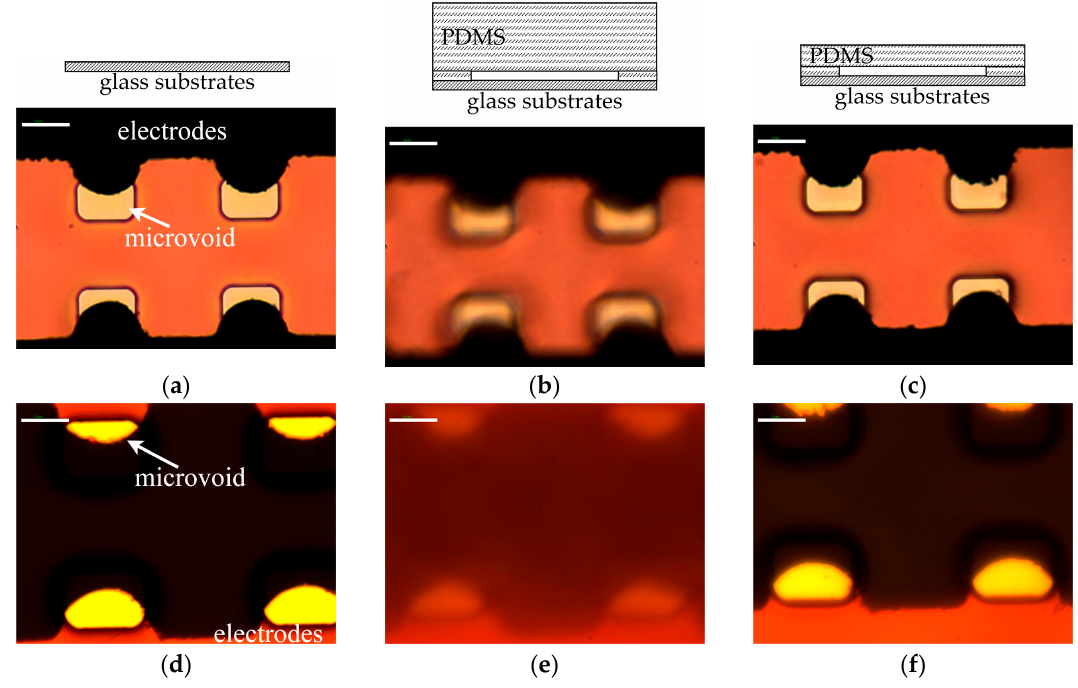
Figure 6. Photographs of Au microelectrodes with microvoids via the objective of ×100/0.6, scale bar: 10 μ m. Microscope images with transmission illumination mode: ( a ) on the glass substrate; ( b ) on the microfluidics chip with a 3 mm thick PDMS block; and ( c ) on the microfluidics chip with a 300 μ m observation interface of a PDMS membrane. Microscope images with reflection illumination mode: ( d ) on the glass substrate; ( e ) on the microfluidics chip with a 3 mm thick PDMS block; and ( f ) on the microfluidics chip with a 300 μ m observation interface of the PDMS membrane.